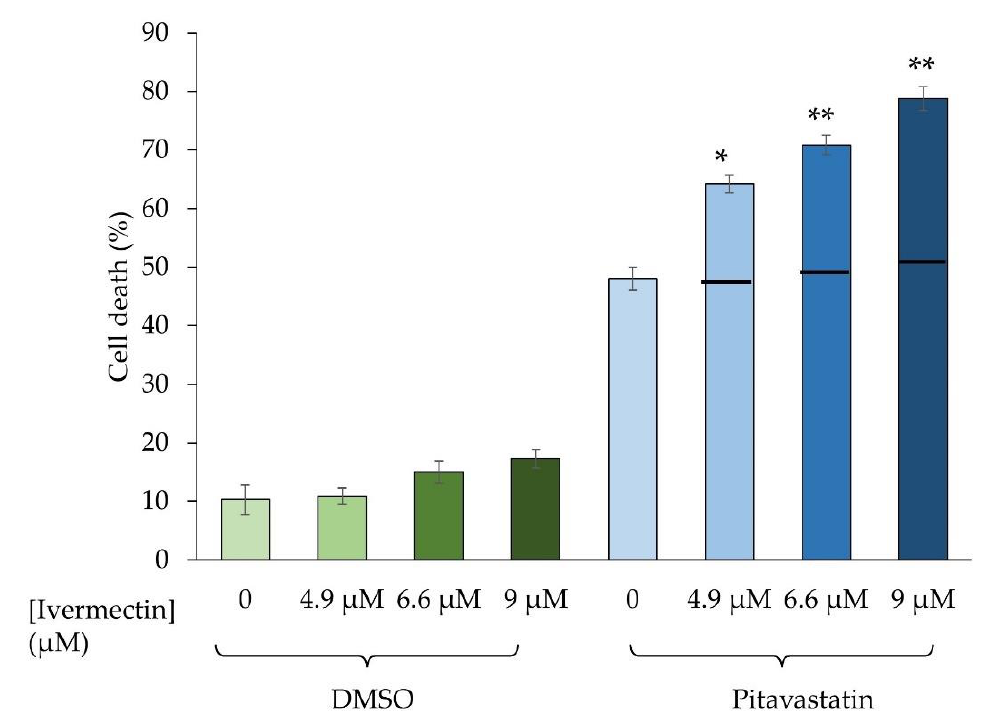
Figure 2. Evaluation of the combination of pitavastatin and ivermectin on cell viability. COV-318 cells were exposed for 72 h to ivermectin (4.9 μM, 6.6 μM, or 9.0 μM) in combination with 6.2 μM pitavastatin. The number of viable and dead cells was determined by staining with trypan blue and the percentage of dead cells calculated (mean ± S.D., n = 3). There were significantly (paired t -test, *, p < 0.01; **, p < 0.005) more dead cells in samples exposed to the combination than would be expected if the drugs acted additively (estimated using the Bliss independence criterion and shown as a horizontal black bar on the graph).